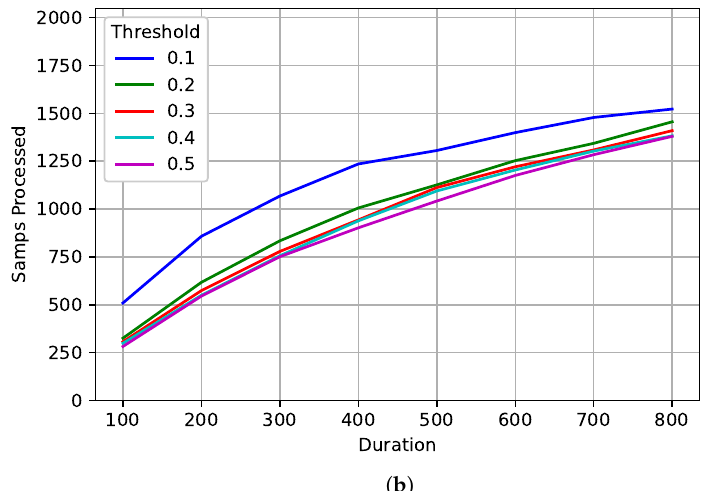
Figure 12. A tradeoff analysis of ( a ) accuracy and ( b ) the number of samples processed of the different JED parameters for the best models trained on 1024